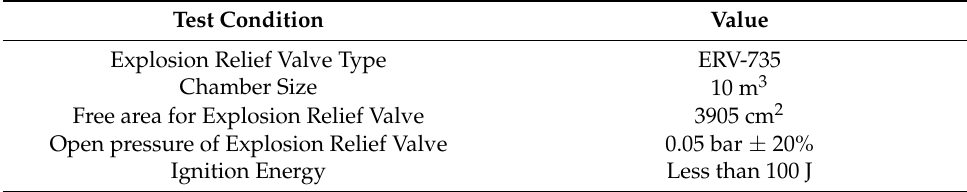
Table 1. Specification of the crankcase explosion relief valve.